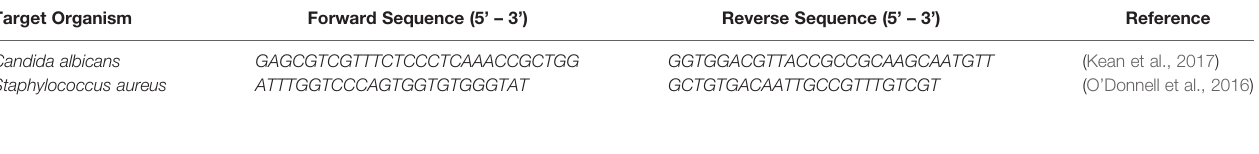
TABLE 1 | Species speci fi c primers used to identify C. albicans and S. aureus